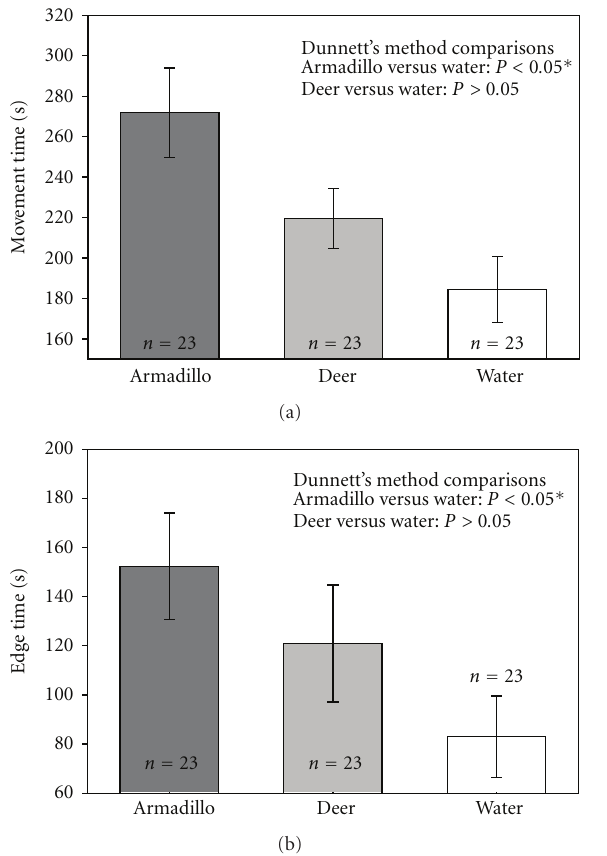
Figure 4: Experiment 2: behavioral responses to airborne cues. Time spent moving (a) and time spent in a flat posture (b) for salamanders exposed to stimuli from armadillos, deer, or blank control water. Bars and error bars represent means ±